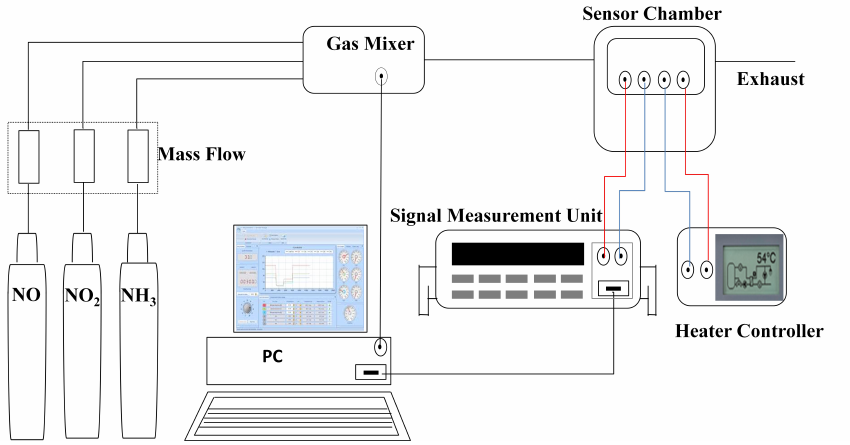
Figure 3. Experimental setup of the HEMT gas sensor for NO x and NH 3